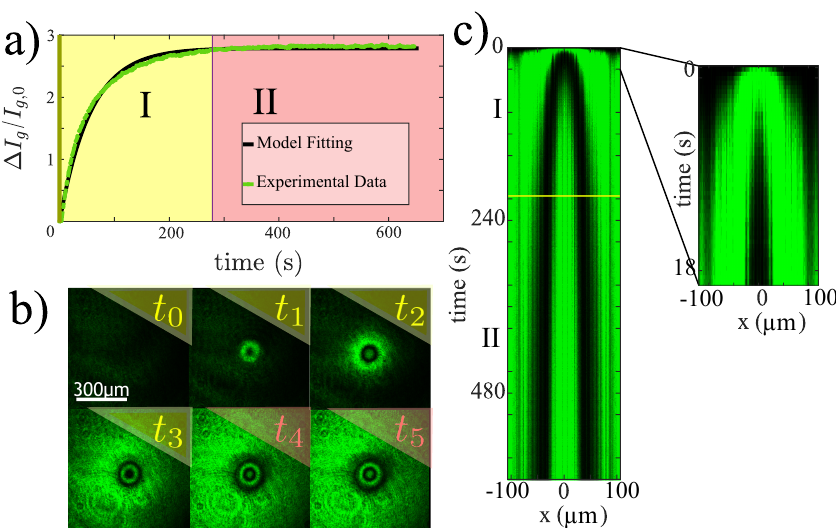
Figure 3. Experimental ring pattern emergence induced by a blue light (with a 445 nm wavelength) applied to a dye-doped liquid crystal cell, E7 NLC with azo-dye methyl red methyl ester at a concentration of 1 wt%. ( a ) Temporal evolution of transmitted total intensity, measured in the green channel of the CCD camera ( ∆ I g ) with respect to the transmitted light without the blue light beam ( I g ,0 ). The points were obtained experimentally, and the continuous curve was acquired using the expression ∆ I g ( t ) / I g ,0 = A ( 1 − e t / τ ) , where A = 2.79 and τ = 55.71 s. Painted areas I and II account for the growth and saturation regions, respectively. ( b ) Temporal sequence of snapshots in the ring pattern formation process ( t 0 = 0 s, t 1 = 1 s, t 2 = 5 s, t 3 = 84 s, t 4 = 360 s, and t 5 = 570 s). ( c ) Spatiotemporal diagram evolution of a diameter cut